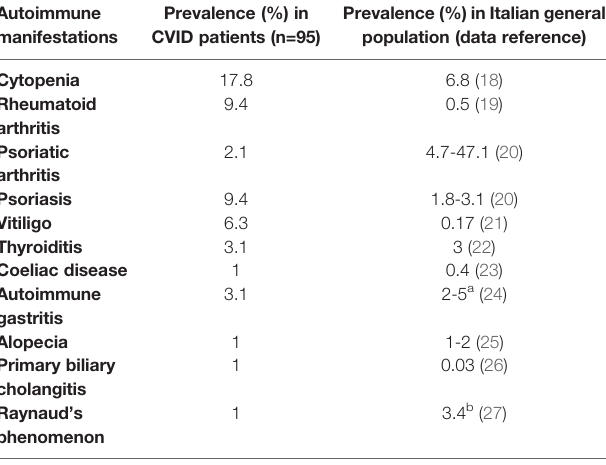
TABLE 2 | Prevalence of autoimmune manifestations in our CVID cohort (n=95) vs Italian general population. Autoimmune manifestations